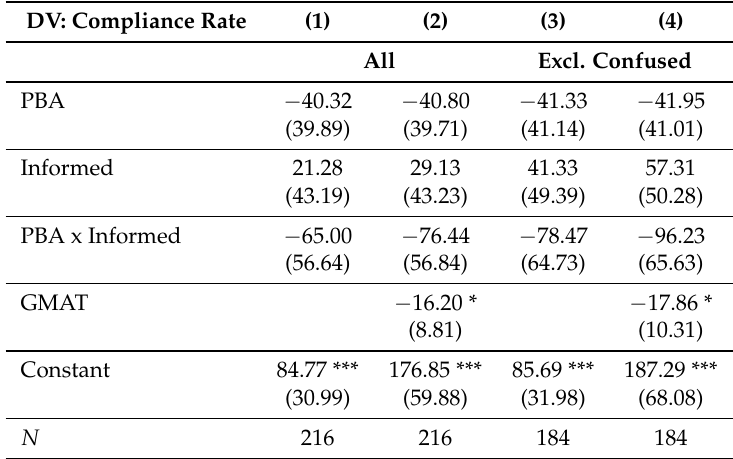
Table A11. Treatment interaction regressions (Tobit).